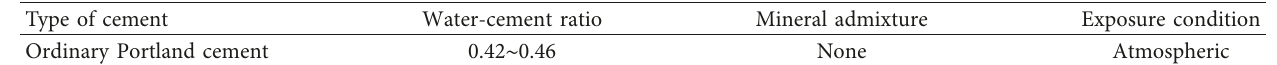
Figure 1: Locations (a), age distribution (b), annual changes of the average values of the ambient temperature (c), and humidity (d) of the concrete bridges in Ningde city. Table 1: Information of the concrete bridges under